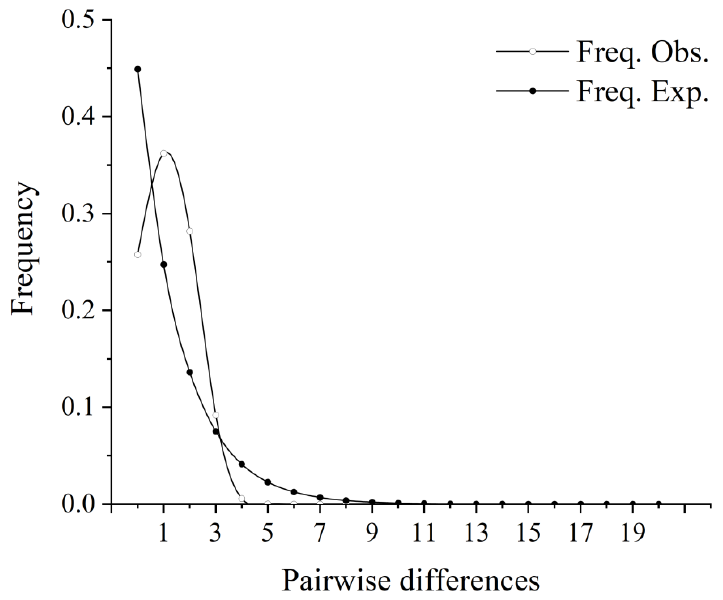
Figure 5. The observed pairwise difference and the expected mismatch distributions of N. taihuensis .